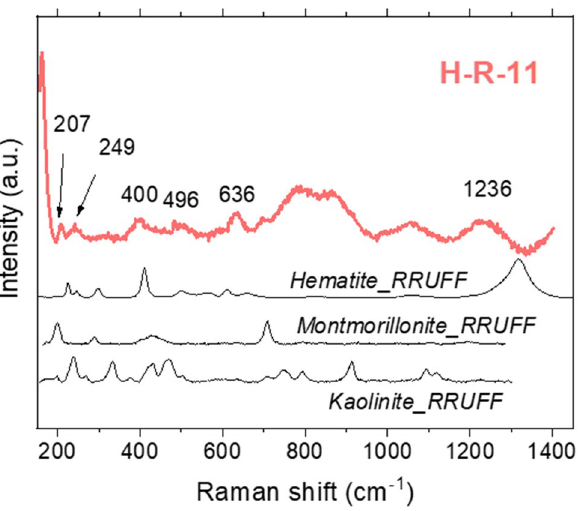
Figure 5. Raman spectrum of the rock sample H-R-11, where kaolinite, montmorillonite and hematite were potentially